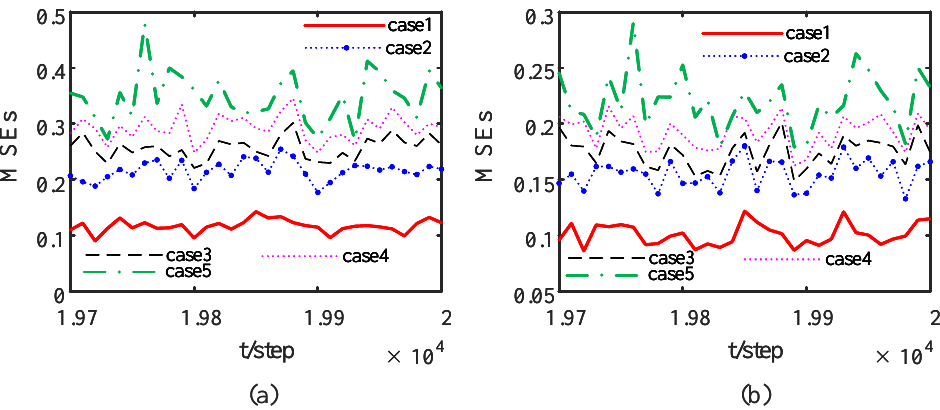
Figure 10. Comparison of MSEs of DSTFCDs with different attack rates of the attack signals: ( a ) MSEs of the position filters; ( b ) MSEs of the velocity filters (authors’ own